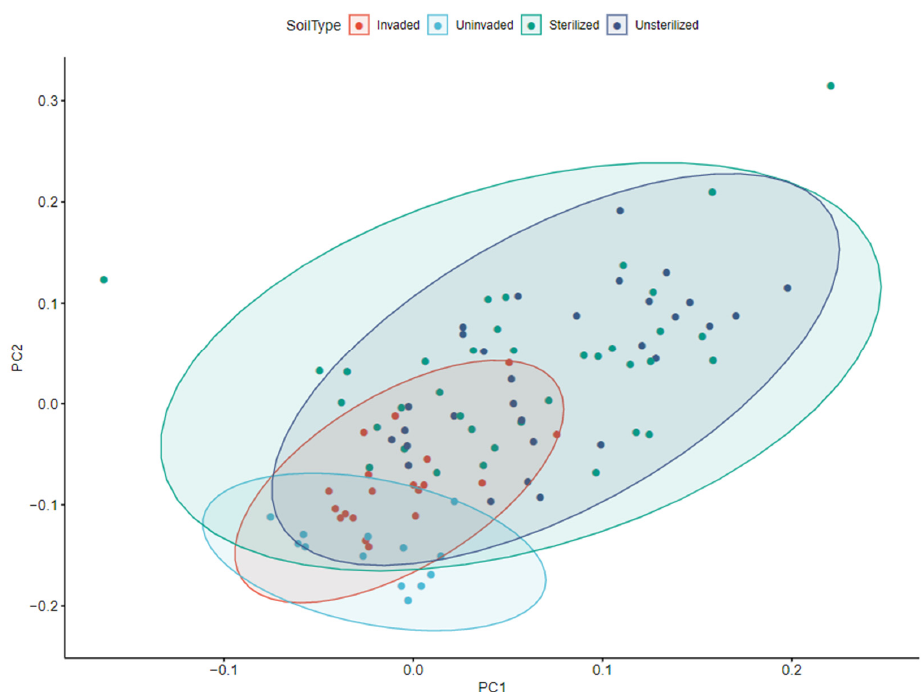
Figure 1. Principal coordinates analysis plot based on the weighted Unifrac distance metric for bacterial taxa in treatment and control plots. Ellipses represent standard deviations of the weighted average of treatments at the 95% confidence level.